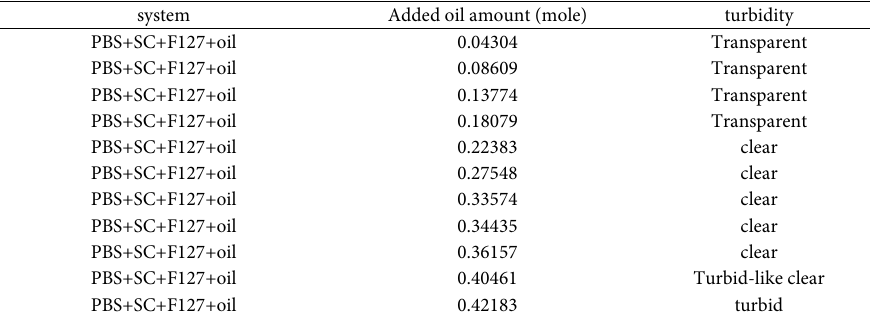
Table 2. The added oil to the oil-in-water F127 microemulsion to determine upper limit for solubilization of oil in microemulsions in the absence of drug ([F127]=0.009 M , [Sodium Caprylate (SC)]= 2.641 M).